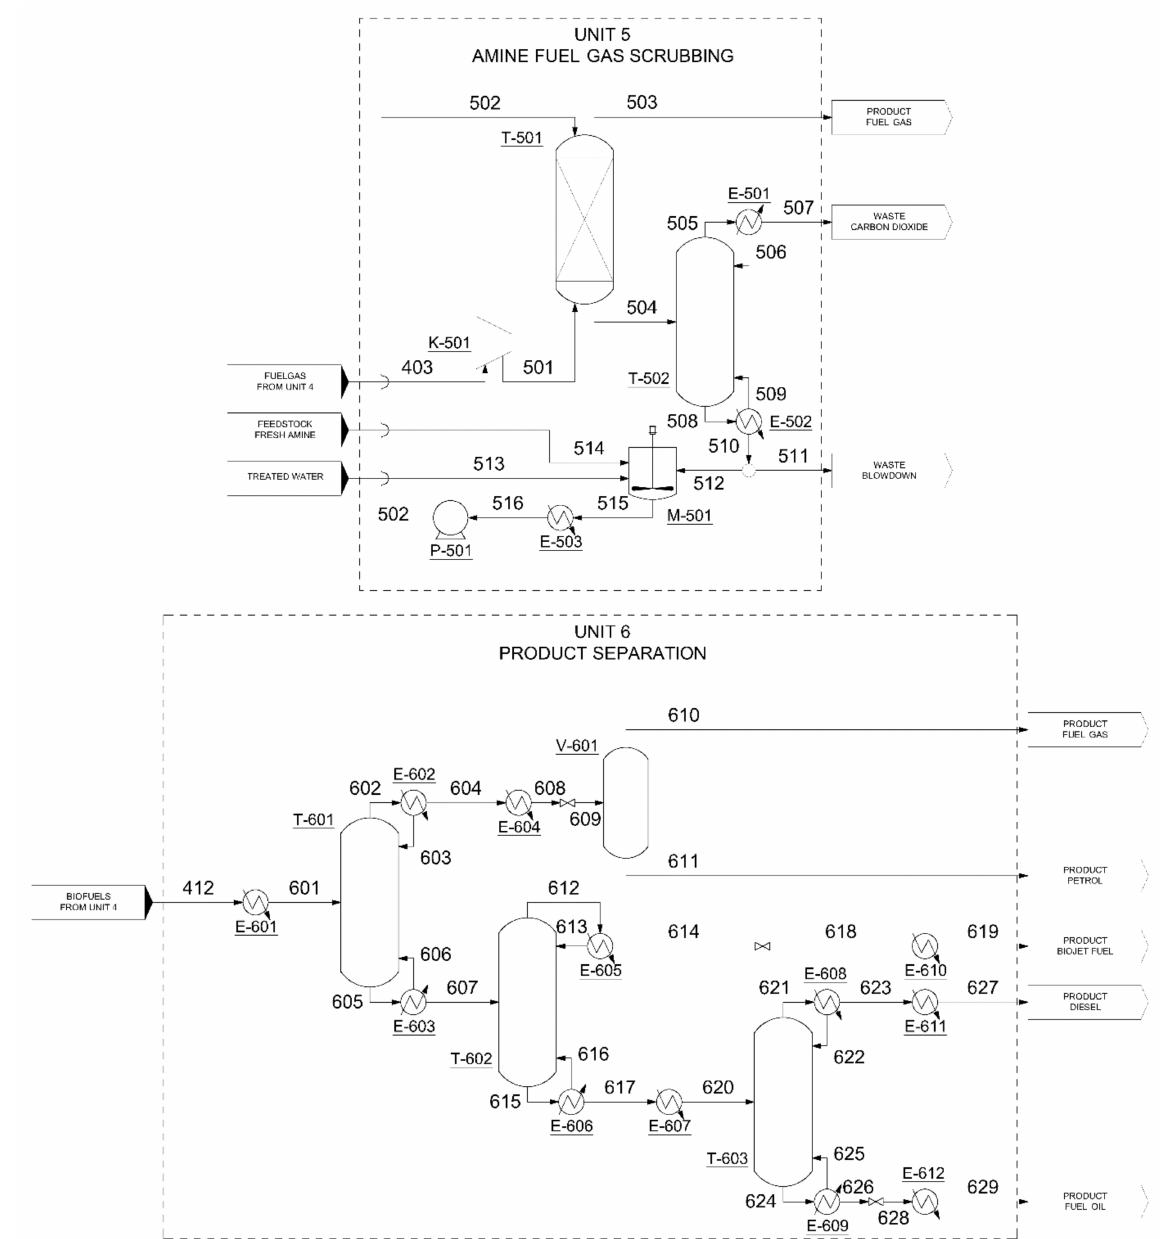
Figure 3. Amine fuel gas scrubbing and product separation (units 5 and